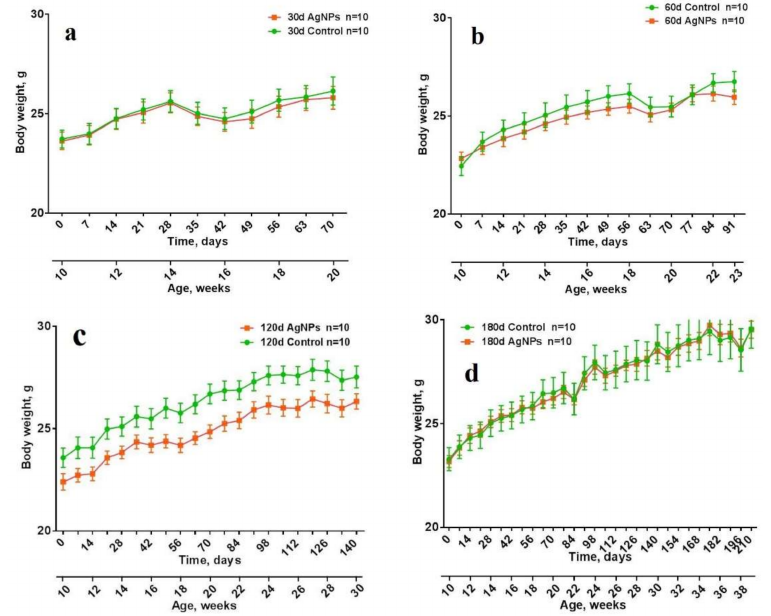
Figure 2. Dependence of the mice body weight on time: “30 days” ( a ); “60 days” ( b ); “120 days” ( c ); “180 days” ( d